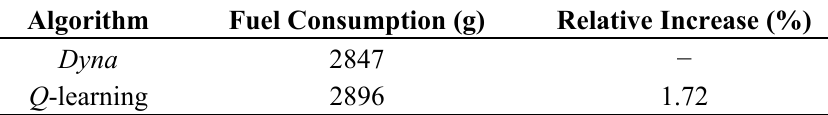
Figure 12. Battery and engine power in the Q -learning and Dyna algorithms. Table 2. Fuel consumption in the Q -learning and Dyna algorithms.